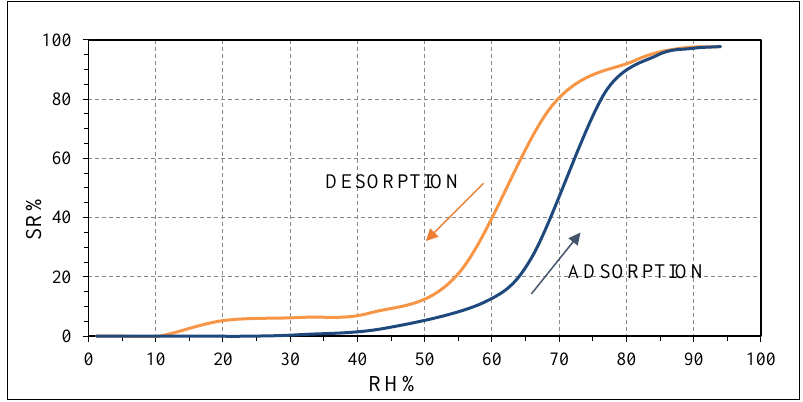
Figure 11. Polyvinylpyrrolidone (PVP) sensor response toward relative humidity.